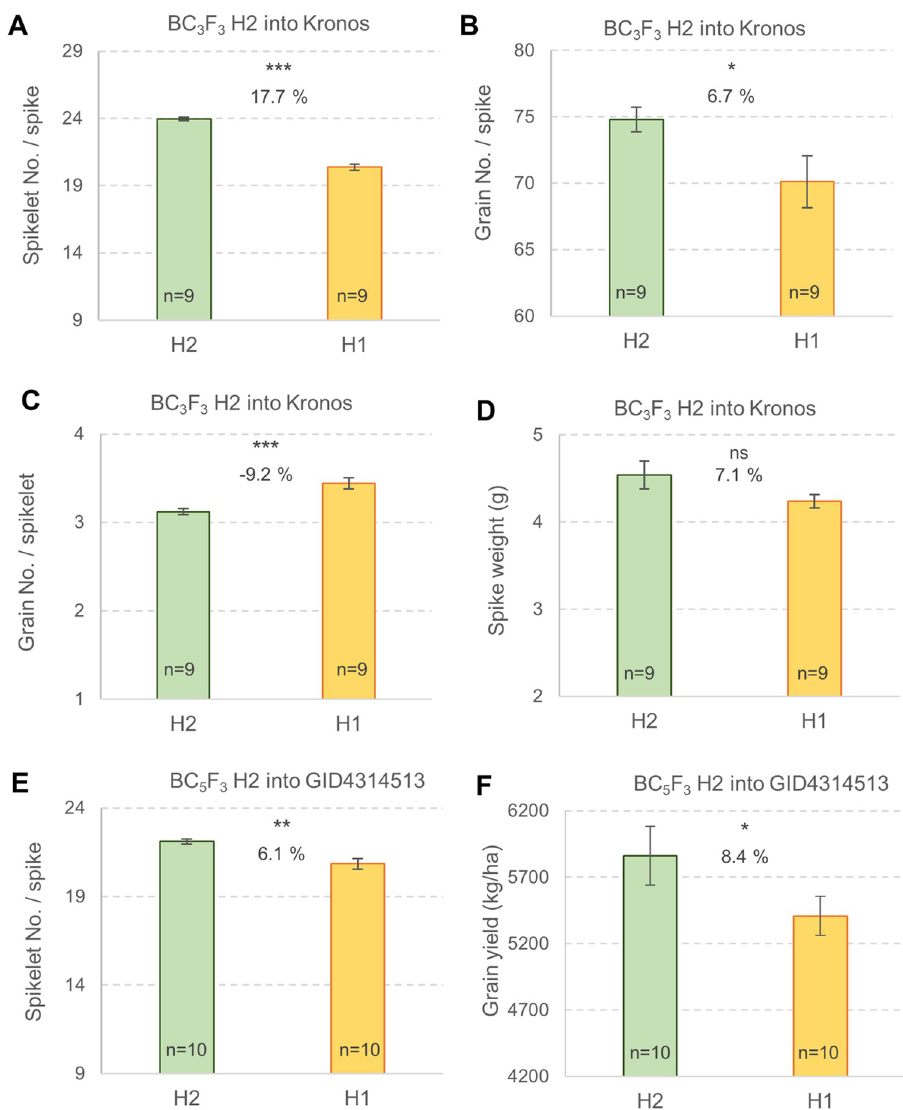
Fig 8. Effect of WAPO-A1 haplotype H2 introgressed into tetraploid Kronos and the high-biomass hexaploid line GID4314513 (both H1). Experiments performed in the field in 2021. ( A-D ) Homozygous BC 3 F 3 sister lines (CRD, n = 9, 1-m rows, 10 spikes measured per row). ( A ) Spikelet number per spike. ( B ) Grain number per spike. ( C ) Grain number per spikelet (spikelet fertility). ( D ) Grain weight per spike. ( E-F ) Homozygous BC 5 F 3 sister lines (RCBD, n = 10, 1.86 m 2 plots, 4 spikes measured per plot). Error bars are s.e.m. ns = not significant, � = P < 0.05, �� = P < 0.01, ��� = P < 0.001. Data used to generate this figure are available in Data H in S1 Data and the statistical analyses in